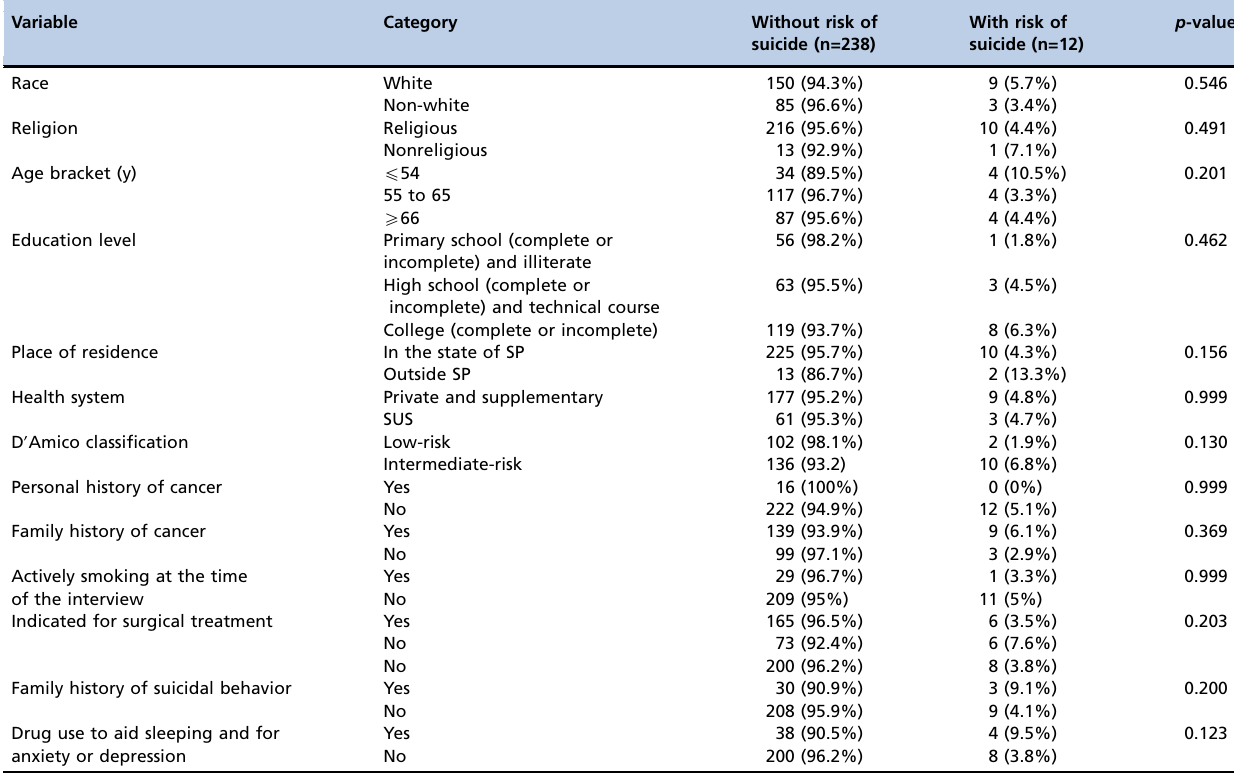
Table 2 - Sociodemographic and clinical data of patients with and without risk of suicide.